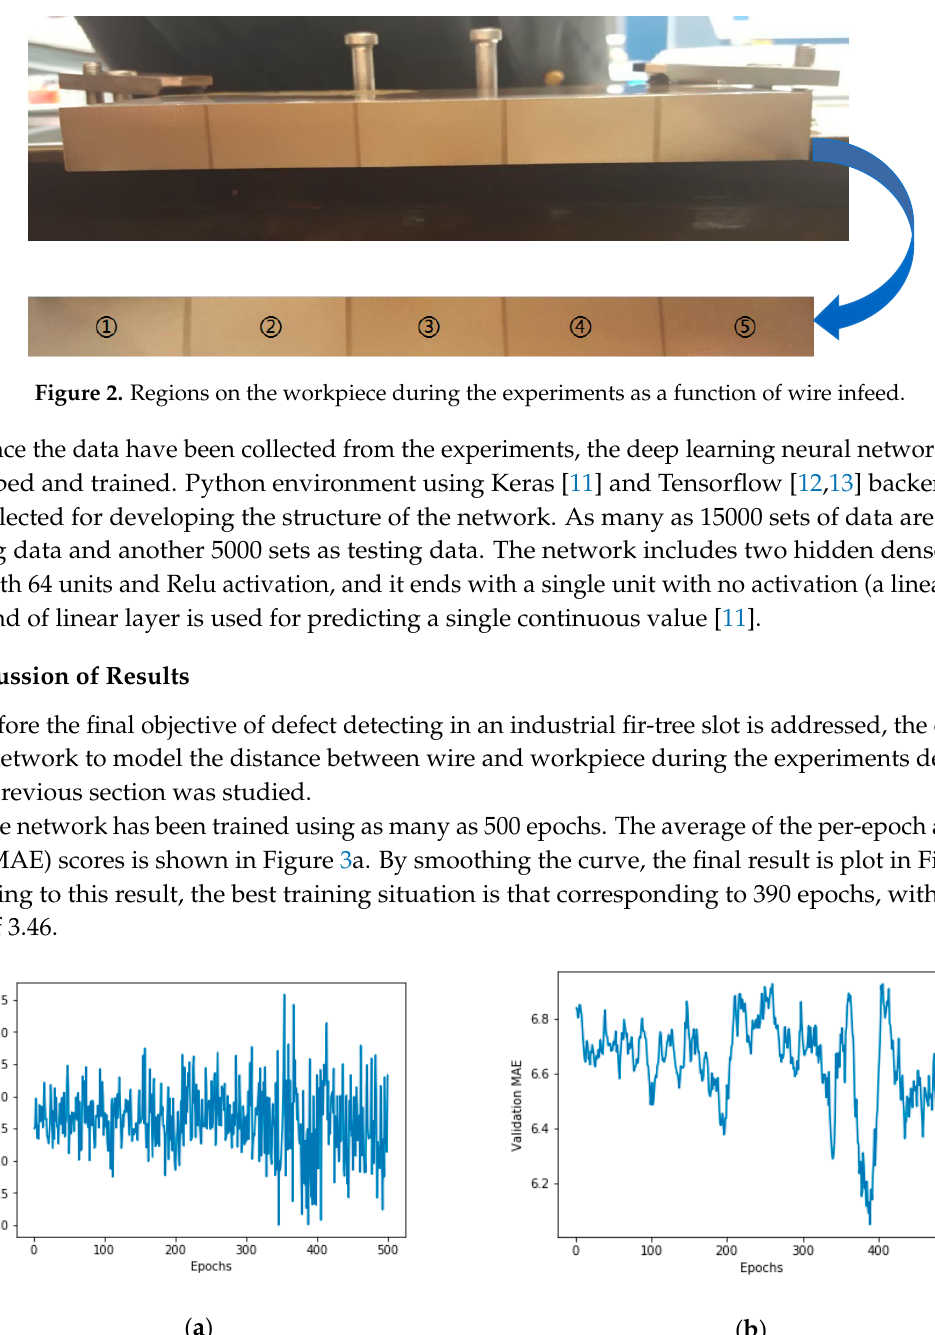
Figure 3. ( a ) Validation through MAE score for every training epoch; ( b ) Plot after smoothing.